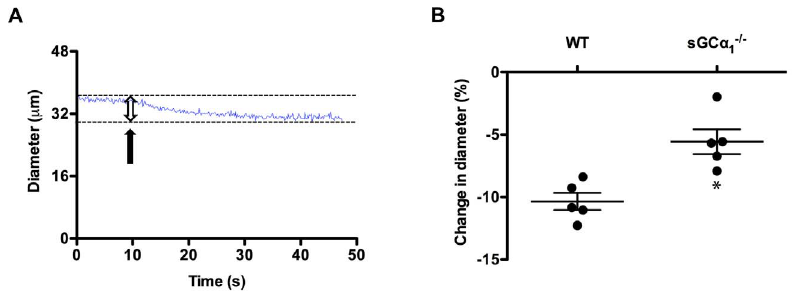
Figure 6. Retinal vascular dysfunction in sGC a 1 2 / 2 mice. A : Representative trace depicting the diameter in one segment of a retinal arteriole in a wild-type (WT) mouse before, during (arrow), and after injection of the NO-donor compound sodium nitroprusside. Dashed lines indicate the diameter before and after sodium nitroprusside injection. B : Quantitative analysis of the change in diameter (double arrow in fig. 6A) induced by injection of 0.8 mg/kg sodium nitroprusside in WT and sGC a 1 2 / 2 mice. n =5 mice (3–4 arterioles per mouse were assessed, see also fig. S3). * P =4.1 6 10 2 3 .